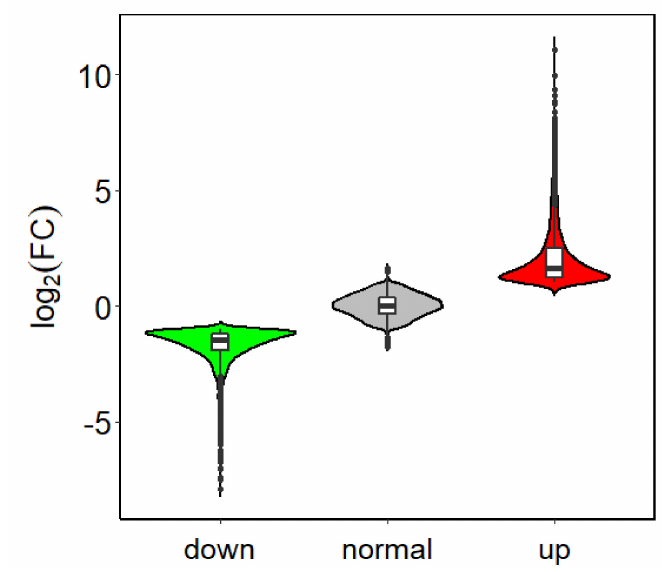
Figure 2. Violin plot of di ff erentially expressed genes in C and PHI.